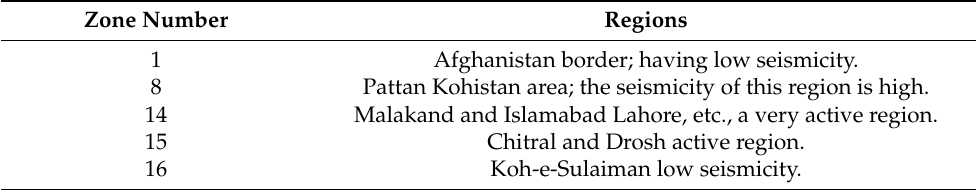
Table 3. Seismicity of source zones in the surrounding area of the Shigo Kas HPP.